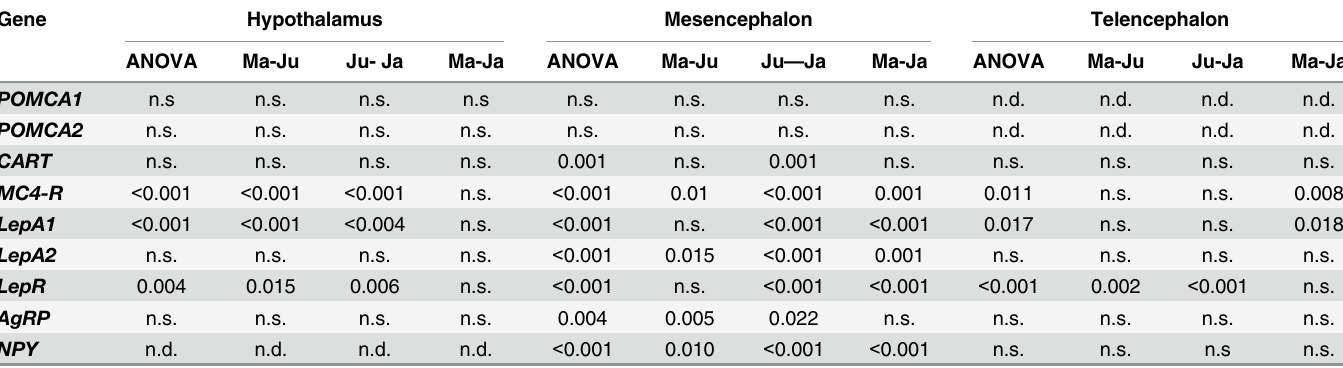
Table 3. Testing for differences across sampling time points (p-values for ANOVA and Tukey ’ s Honestly-Significant-Test).